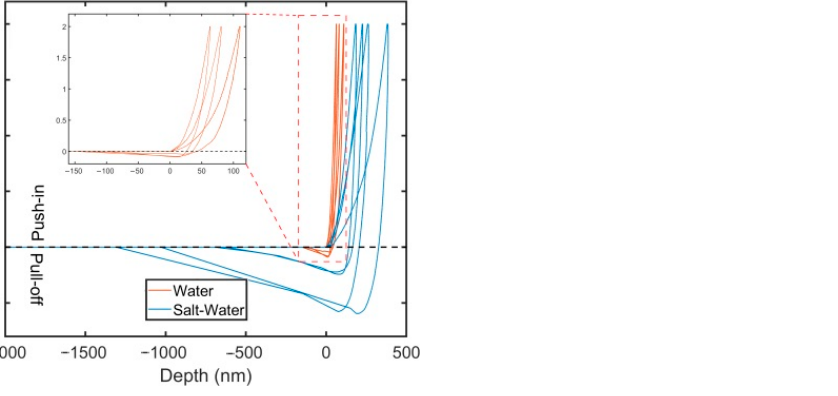
Figure 3. Nanoindentation depth–load curves obtained from the cylindrical flat punch adhesion testing for the polySBMA coatings soaked in water and saltwater. The inset shows a magnification of the results in deionized water.